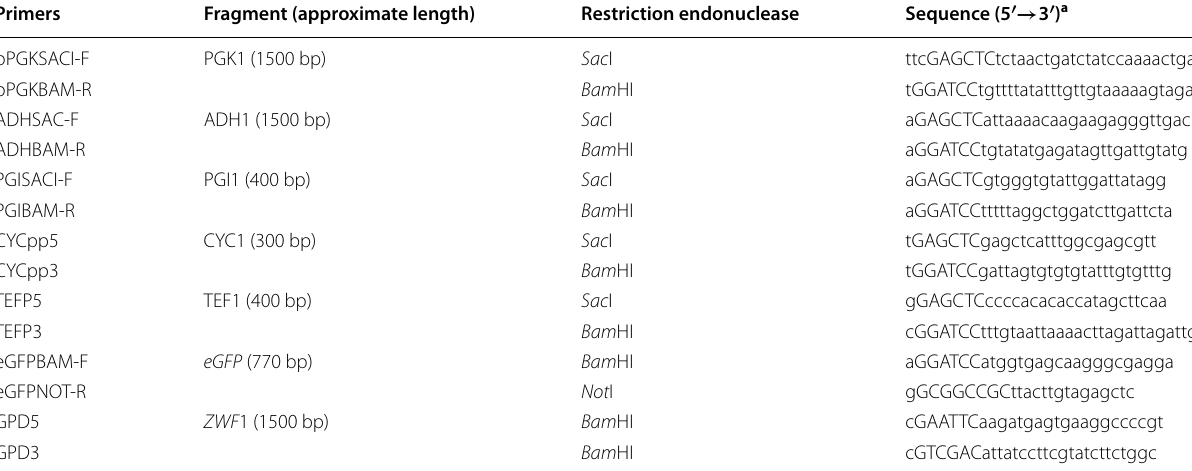
Table 1 Primers used in this